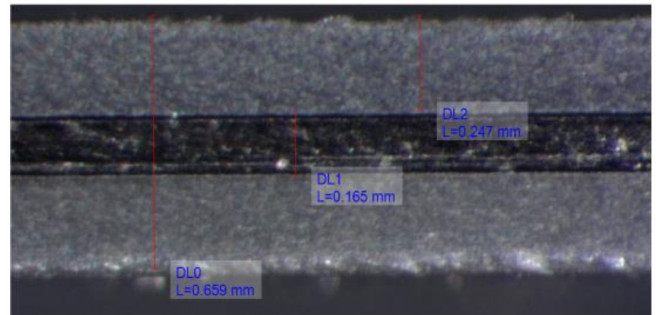
Figure 13. An example of the layer thickness